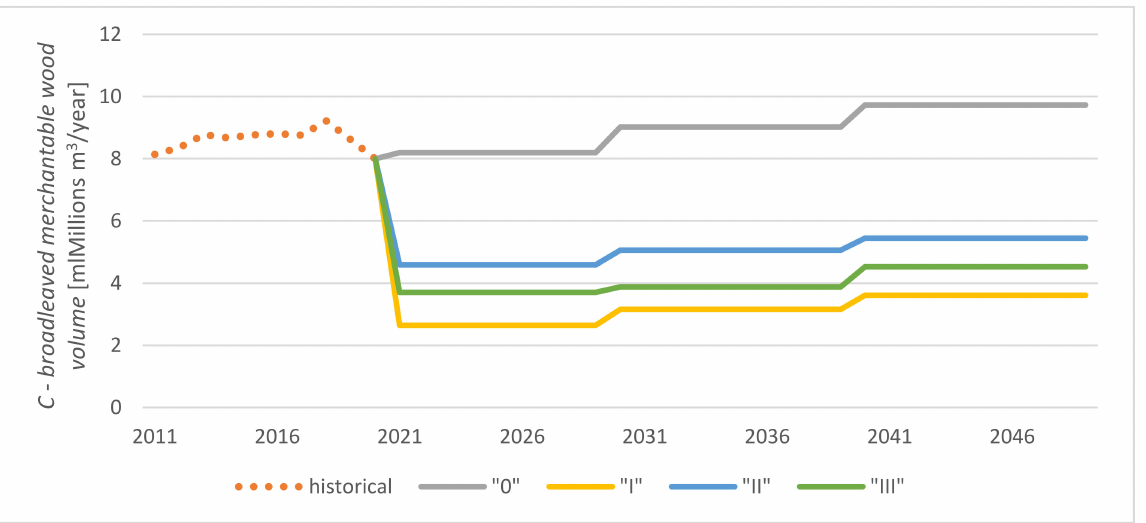
Figure 3. Change in the total amount of merchantable broadleaved wood volume in the scenarios against the background of the historical amount of merchantable broadleaved wood